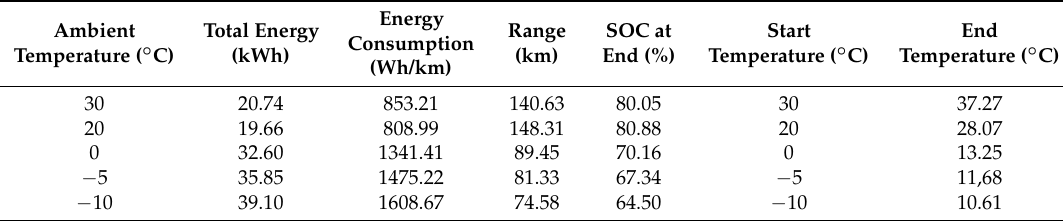
Table 4. Energy consumption by an electric bus with a resistive thermal conditioning system depending on changes in ambient temperature.